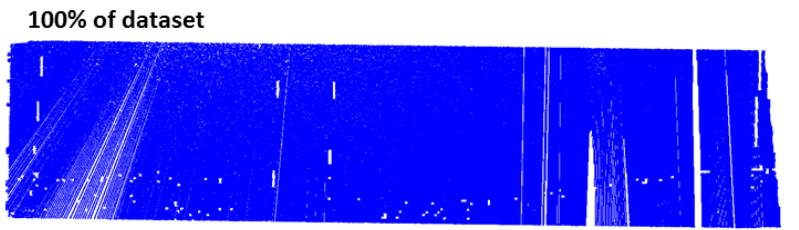
Figure 5. Whole test area (694,185 points).